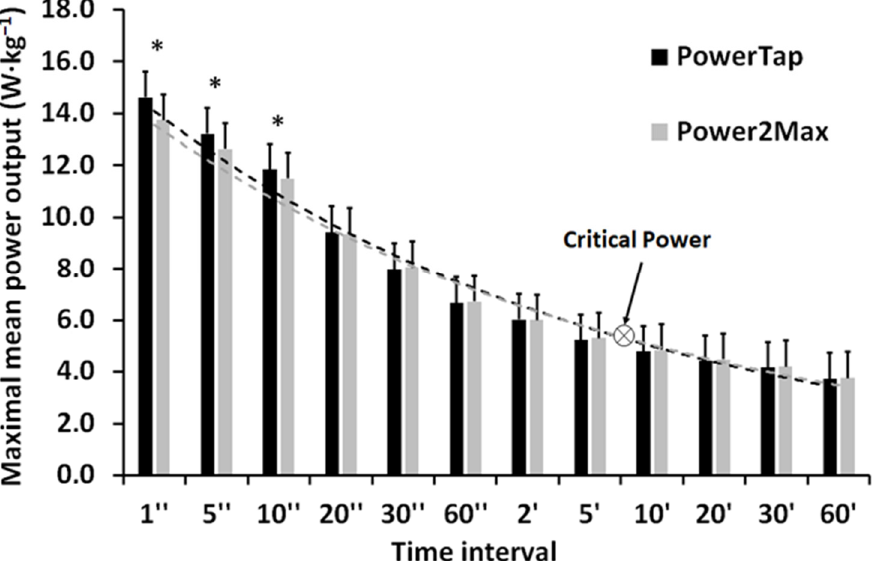
Figure 2. Mean ± SD of the maximal mean power output registered by the PowerTap and Power2Max power meters in each time interval during the six official cycling competitions. Critical power obtained from the PowerTap (dashed black line) and Power2Max registry (dashed grey line). * = significant differences ( p < 0.05) between both power